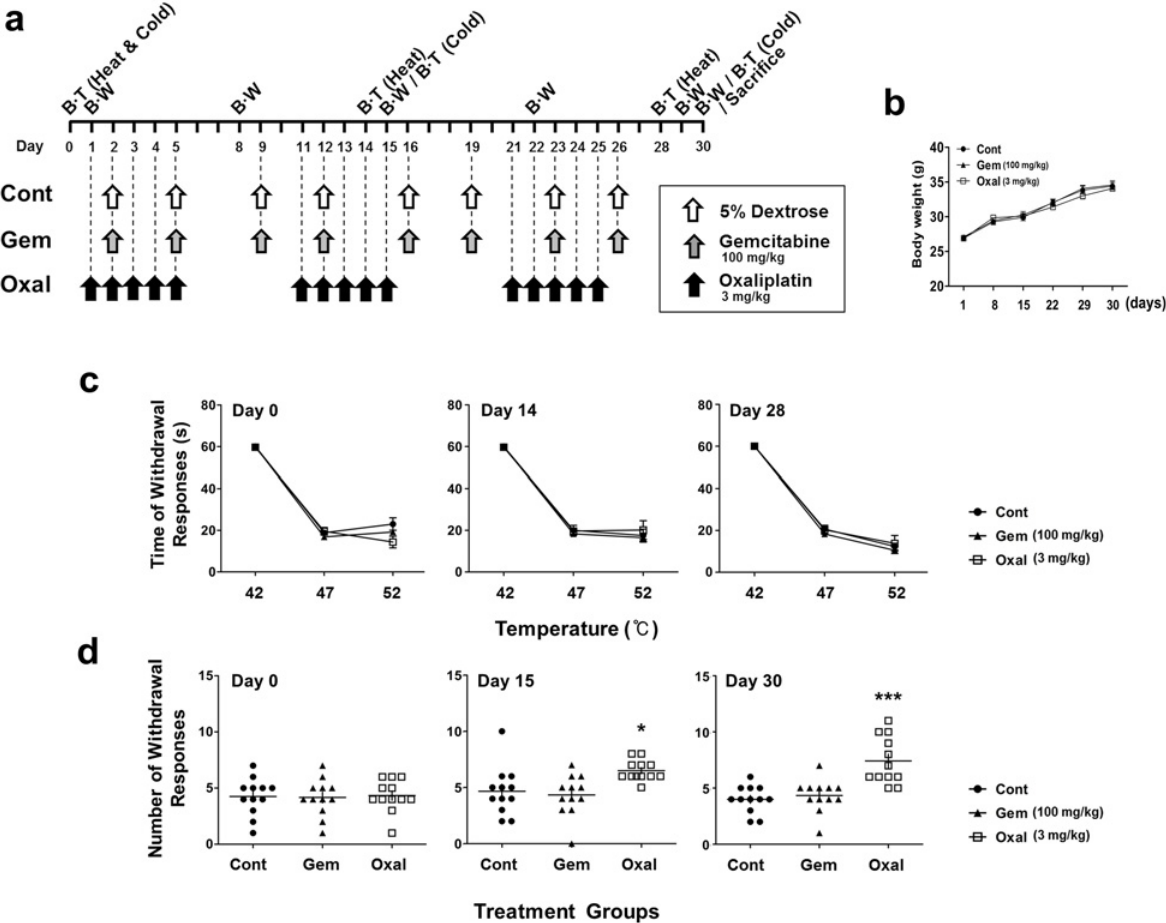
Fig 1. Peripheral neuropathy induced by platinum-based oxaliplatin. 5% dextrose (Cont), gemcitabine (100 mg/kg; Gem), and oxaliplatin (3 mg/kg; Oxal) were administered by i.p. injection for 30 days as shown in the schedule (a). Body weight was measured at 7-day intervals from the initial treatment (b). Hot plate test for thermal hyperalgesia was performed before the first infusion and again every 14 days. There was no significant difference between control ( ● ) and drug-treated ( ▲ : gemcitabine, □ : oxaliplatin) mice (c). Acetone test for cold allodynia was performed before the first infusion and repeated every 15 days. On day 30, paw withdrawal responses to cold stimuli were significantly increased in only the Oxal group (d). Results are representative of two independent experiments. Values are expressed as the mean ± SEM ( n = 12 per group). * p < 0.05, *** p < 0.001 compared with the control group. BT: behavioral test, BW: body